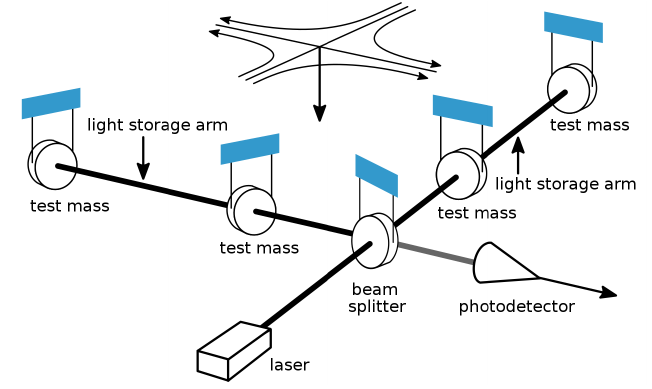
Figure 17: Sketch of the gravitational wave detector